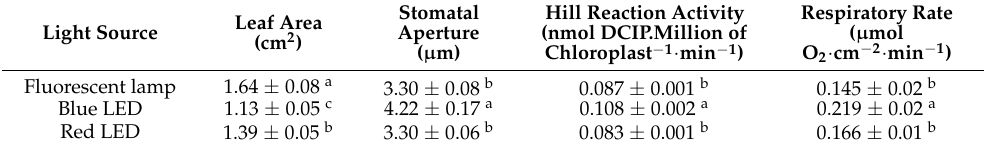
Table 1. The leaf area, stomatal aperture, Hill reaction activity, and respiratory rate of H. corymbosa (L.) Lam leaves after 4 weeks of being grown under different light sources at 100 µ mol · m − 2 · s − 1 light